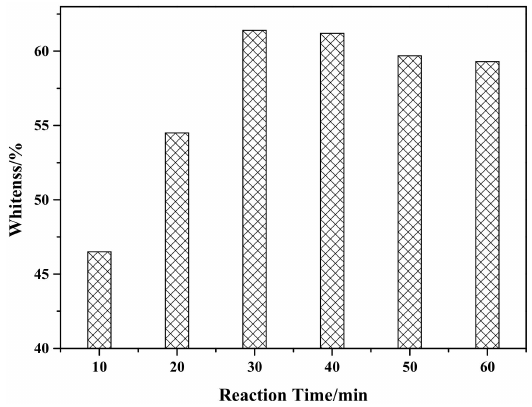
Figure 7. The e ff ect of reaction time on whiteness of ZCFA